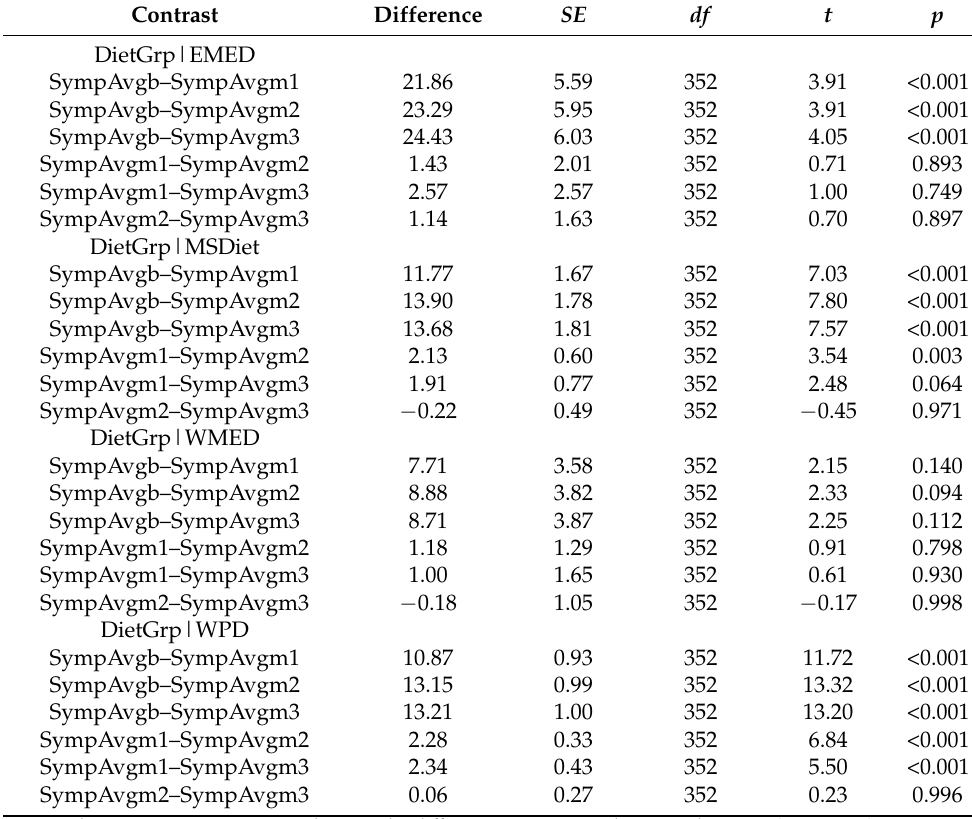
Table 12. The marginal means contrasts for each combination of within-subject variables for the mixed model